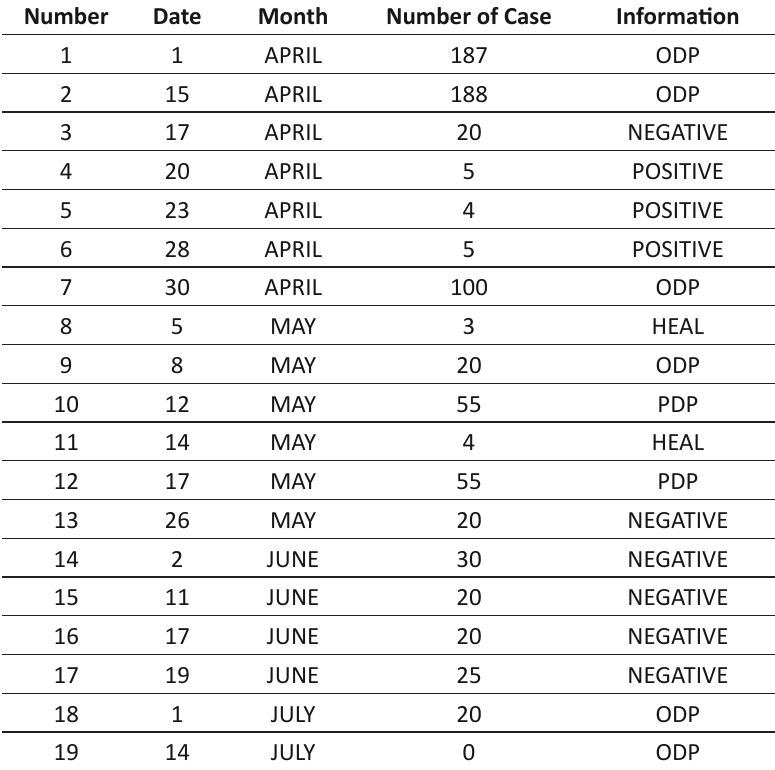
Table 3: Daily Case of Covid-19 in Merauke District